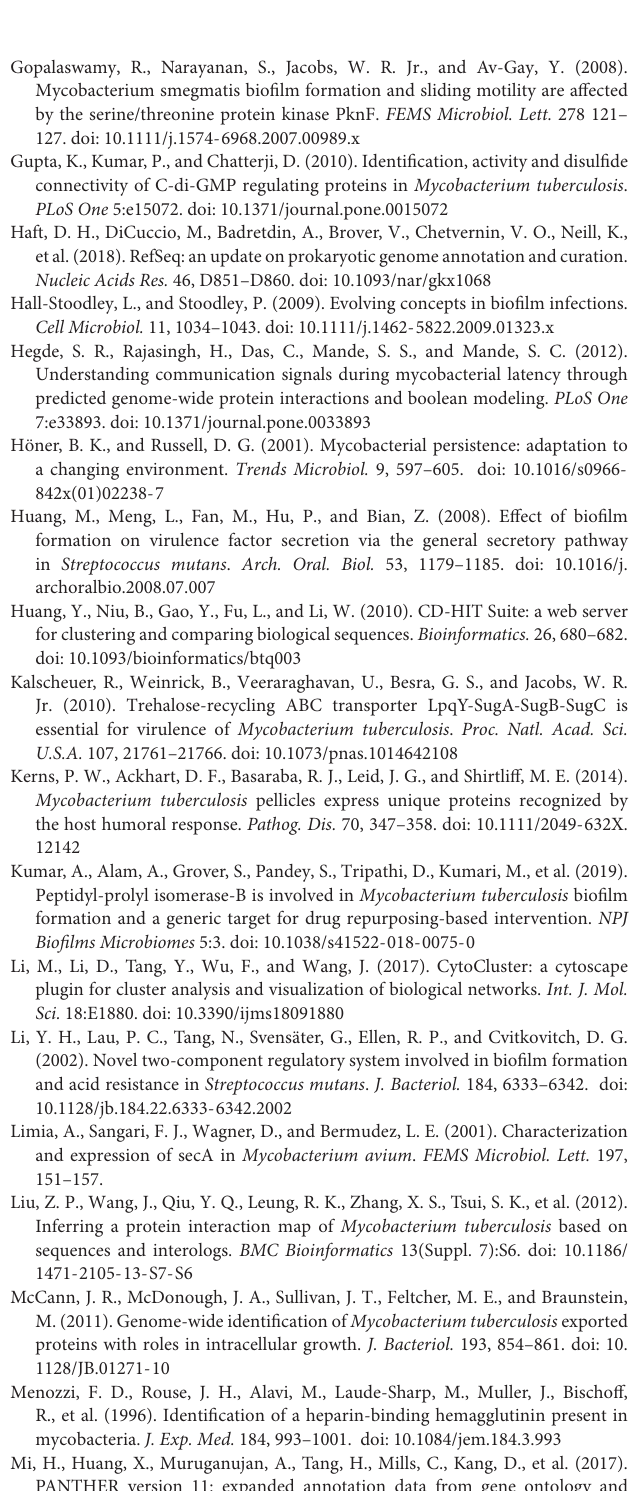
TABLE S2 | Percent identities of the conserved BQAP homologs across biofilm forming bacteria. TABLE S3 | Molecular interaction network of the BQAPs.